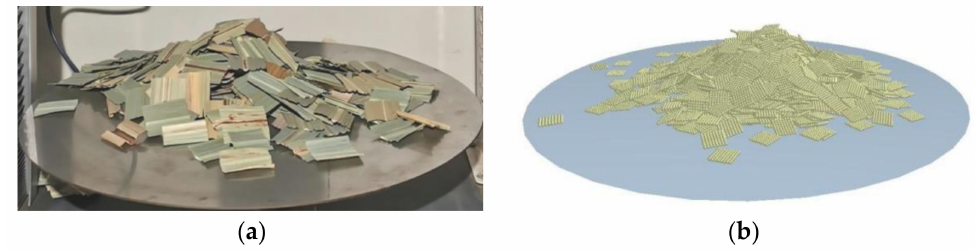
Figure 14. Test comparison of the angle of repose for sugarcane leaves: ( a ) physics test, ( b ) simulation